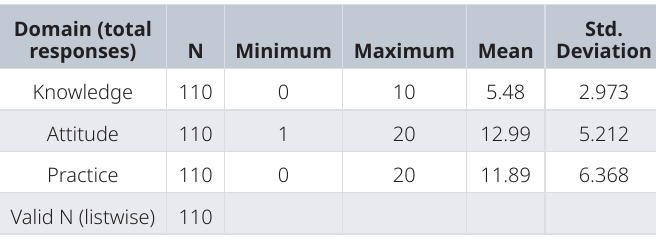
Table 5. Descriptive statistics of knowledge, attitude, and practice scores for whole sample.